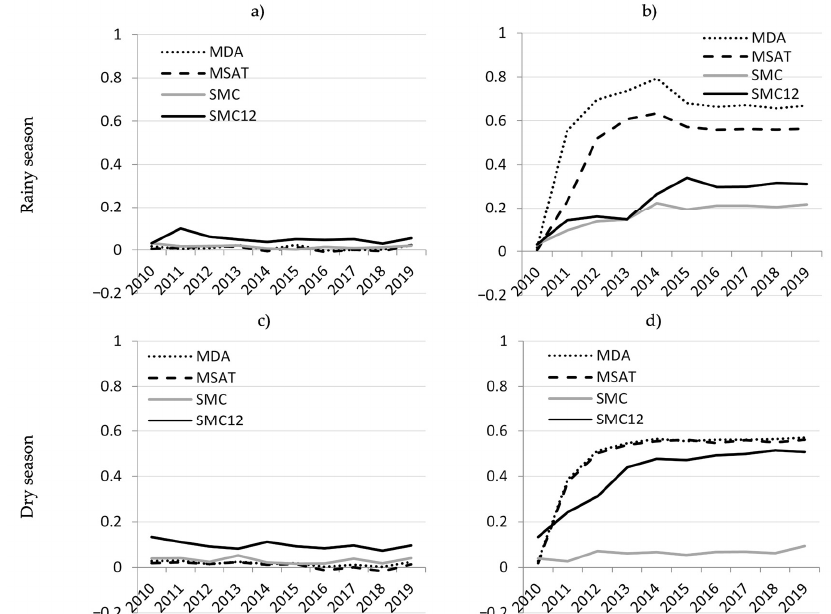
Figure A2. Decrease in malaria incidence while targeting one third of HT hotspots in Mbour, Senegal 2008–2012. The y-axis represents intervention efficacy (relative decrease in overall malaria incidence). ( a ) Unique one-year intervention during rainy season, ( b ) Repeated interventions on five consecutive rainy seasons, once per year, ( c ) Unique one-year intervention during the dry season, ( d ) Repeated interventions on five consecutive dry seasons, once per year.